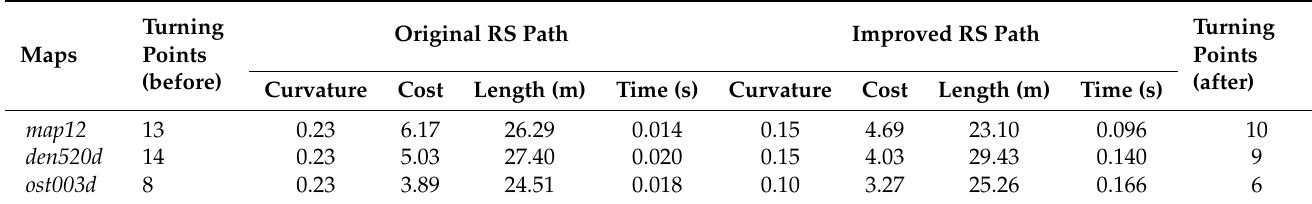
Table 2. Comparison of original and improved methods in benchmark